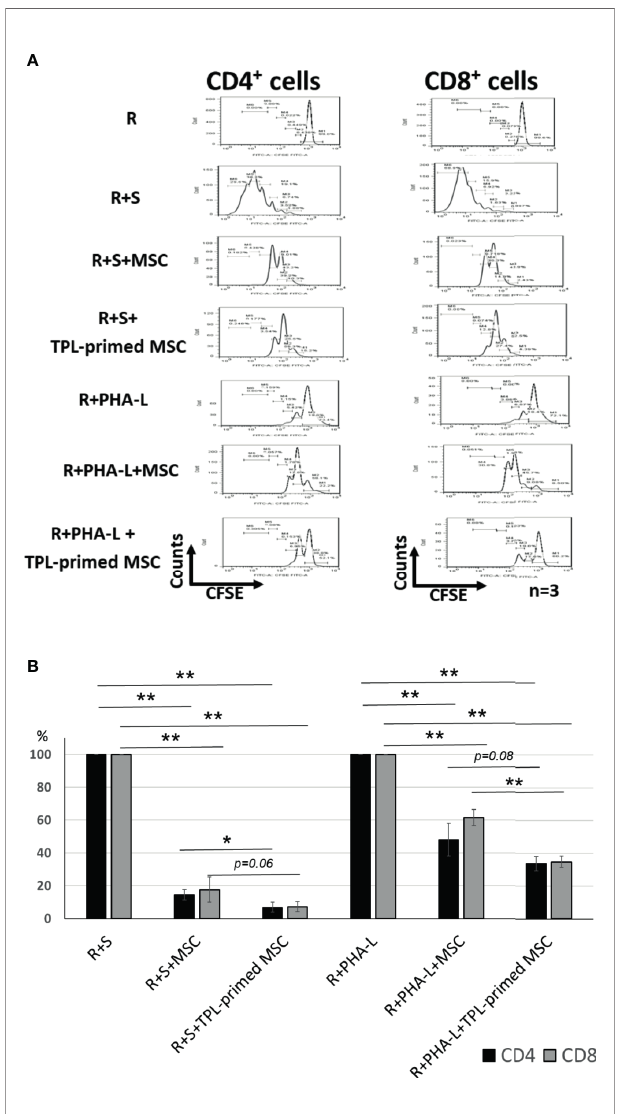
FIGURE 3 | The immunosuppression effect of TPL-primed UC-MSCs. (A) TPL-primed UC-MSCs show stronger anti-proliferative effect for activated CD4+ and CD8+ T cells in allogeneic MLR compared with the non-primed UC-MSCs. TPL-primed UC-MSCs exhibit stronger anti-proliferative effect for activated CD4+ and CD8+ T cells on PHA-L stimulated responder cells. (B) Comparison of the (%) inhibition of TPL-primed UC-MSCs and UC-MSCs in allogeneic MLR. There are signi fi cant differences of inhibitory effect by UC- MSC with or without TPL priming. Quantitative data have been presented as the mean value of three different samples ± SD with *p < 0.05, **p <